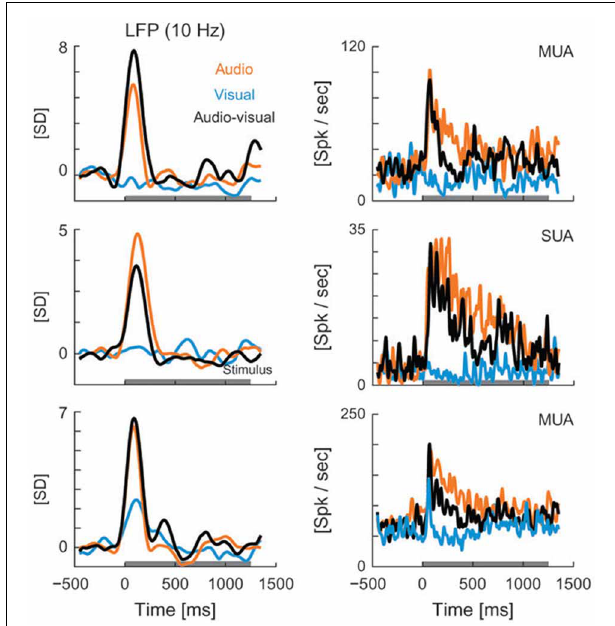
FIGURE 4 | LFPs (left column) and spiking activity (right column) recorded from auditory cortex in rhesus monkeys presented with visual (blue), auditory (orange), and audiovisual (black) stimuli. LFP curves demonstrate the mean values for each of the 3 stimulus conditions, with the horizontal gray line along the x axis representing the stimulus interval. LFP values are shown in units of standard deviation (SD) from baseline (z-score). MUA, multi-unit activity; Spk, spikes; SUA, single-unit activity [reprinted with permission from Kayser et al.